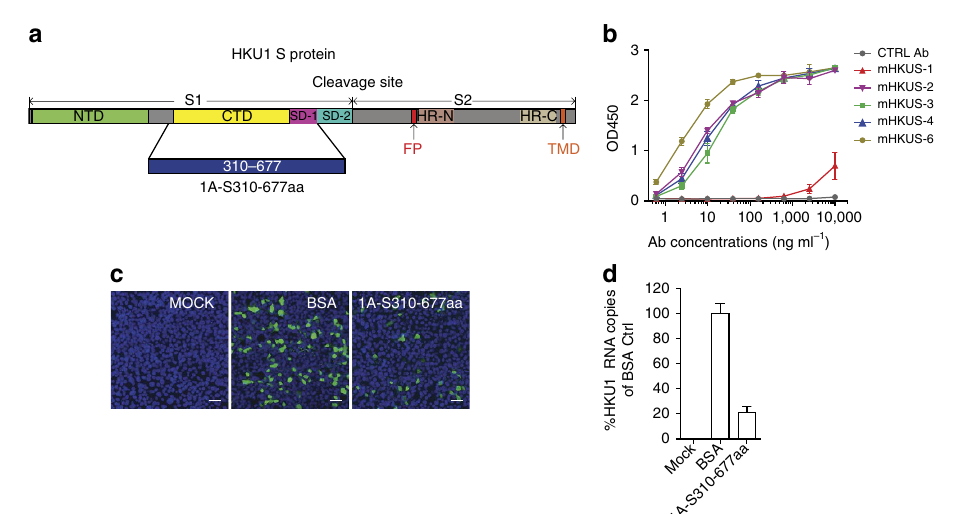
Figure 1 | Inhibition of HKU1 virus infection by 1A-S310-677aa. ( a ) Schematic diagram of HKU1 S protein, modified from Kirchdoerfer et al 18 . NTD, N-terminal domain; CTD, C-terminal domain; SD-1, subdomain-1; SD-2, subdomain-2; RBD, receptor-binding domain; FP, fusion peptide; HR-N, N-terminal heptad repeat; HR-C, C-terminal heptad repeat; TMD, transmembrane domain; cleavage site, furin cleavage site between S1 and S2. The amino